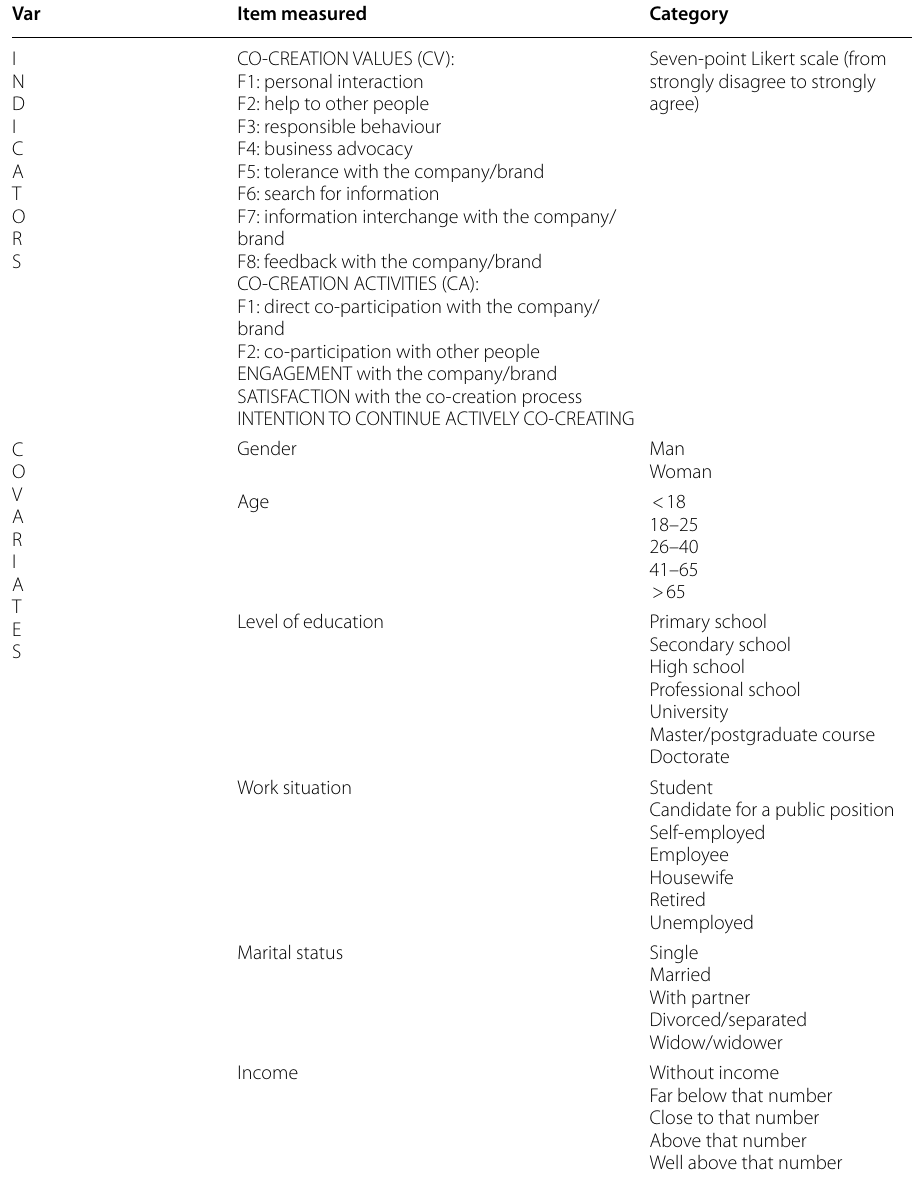
Table 8 Measured variables: indicators and covariates Var Item measured